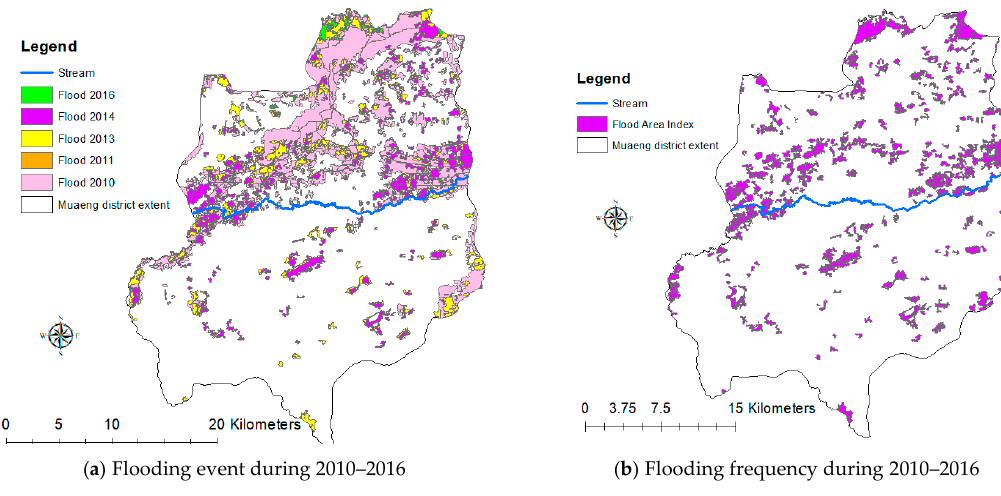
Figure 7. Maps of flood change in ( a ) and Flood Area Index ( FAI ) in ( b ). Table 4. Comparison of stream order length of Year 2018/2022.